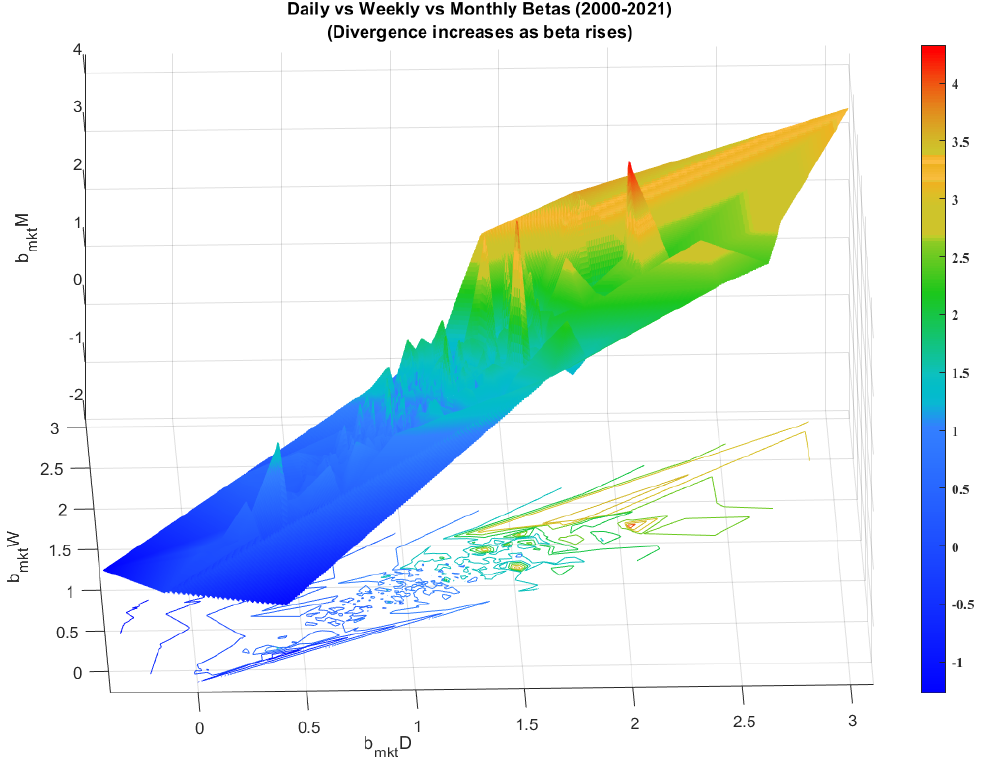
Figure 2. Surface plot of betas derived from daily, weekly and monthly returns (2000 − 2021). The frequency of returns does seem to impact the estimated beta values and the 1-period forward return tracking errors. In Figure 3, we observe that of the three types of betas, the one using the weekly return frequency has, for most market capitalization groups, the lowest tracking error for 1-period forward returns (higher bars are better). The ‘purple’ colored bars are for the Large Cap stocks and have the highest occurrence of the lowest observed tracking errors, especially for the weekly return series and for the 3-, 4- and 5-year estimation period. The 1-year and 2-year window length estimation period yields the most unstable betas, particularly for the daily and monthly return frequencies (lowest occurrence of low TE’s). The ‘maroon’ colored bars are for Mid Cap stocks and have the highest occurrence of the lowest observed tracking errors for the daily return series (3 and 4 year) estimation periods. Figures A1 and A2, in the Appendix A provide a visual representation of the distribution of the three beta series and their overlap densi- ties.